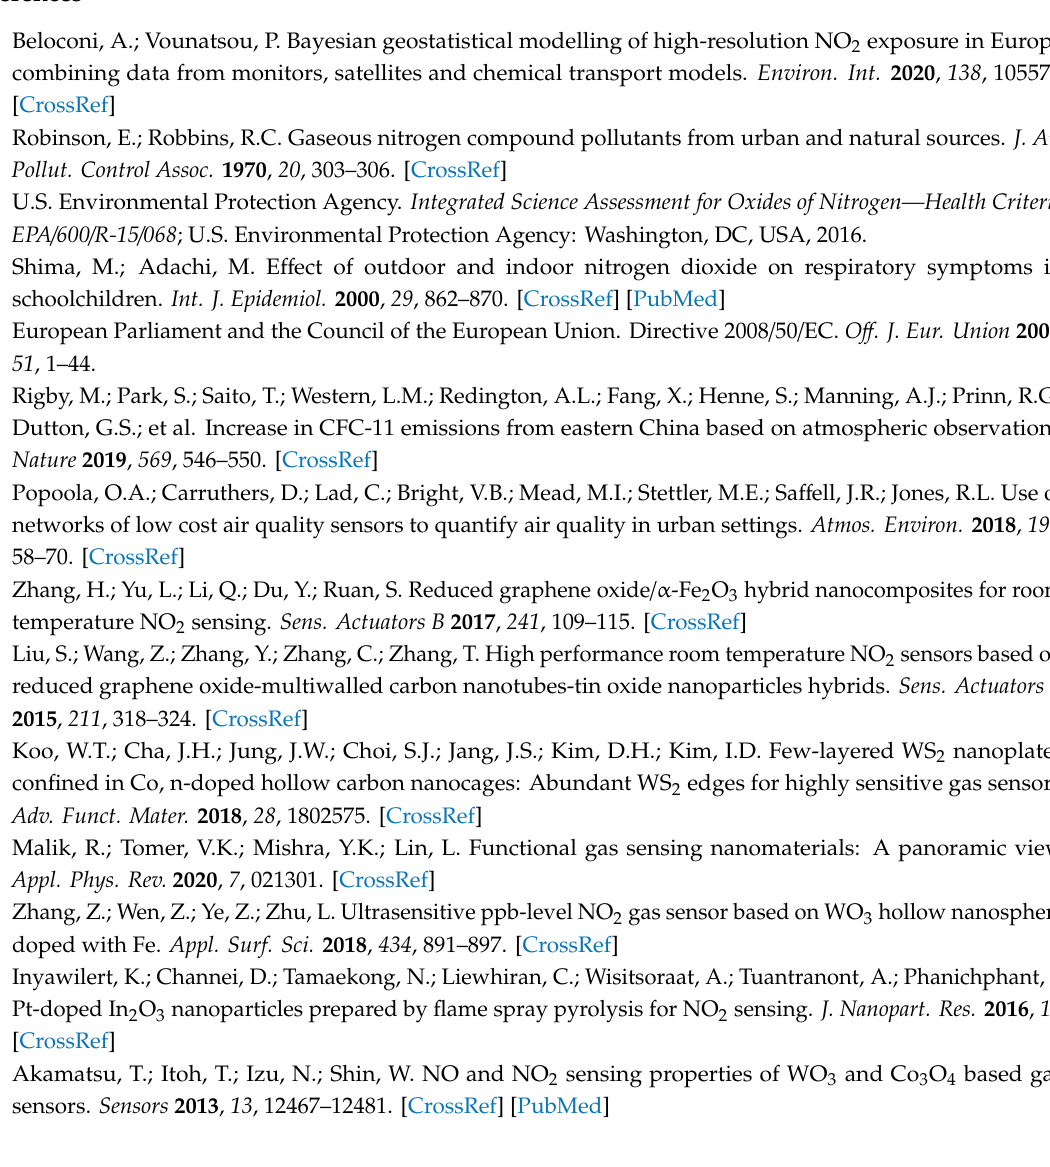
Figure S1: Sensor chamber, Figure S2: Phase determination by X-ray di ff raction, Figure S3: Extended XRD spectrum of the WO 3 powder, Figure S4: Film thickness determination, Figure S5: Flame-deposited WO 3 films on Al 2 O 3 , Figure S6: WO 3 film thickness on Al 2 O 3 as a function of deposition time, Figure S7: Drift, Figure S8: The e ff ect of higher CO concentrations, Table S1: Optimum WO 3 temperatures for NO 2 sensing, Table S2: Porosity evaluation by X-ray di ff raction, Table S3: Film thickness e ff ect on